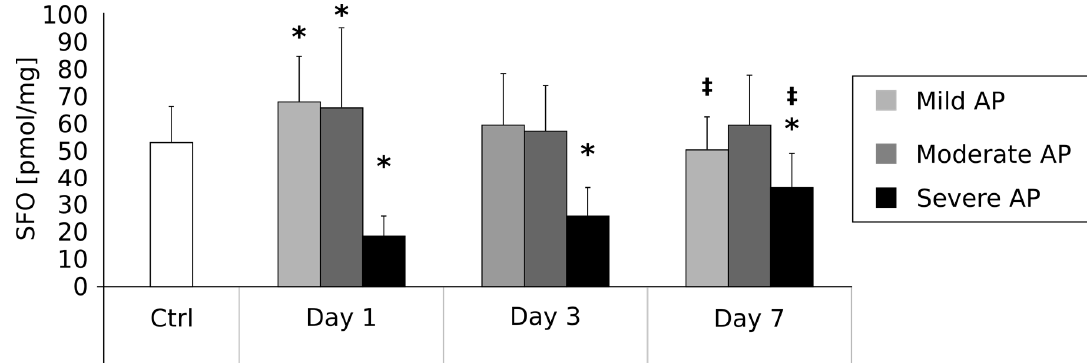
Figure 3. Alterations in sphingosine (SFO) concentrations (pmol/mg) in the course of acute pancreatitis. * = difference vs. Control, p < 0.05; ‡ = difference vs. Day 1, p < 0.05.